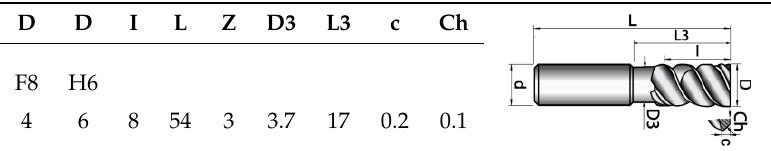
Table 8. Main tool features.